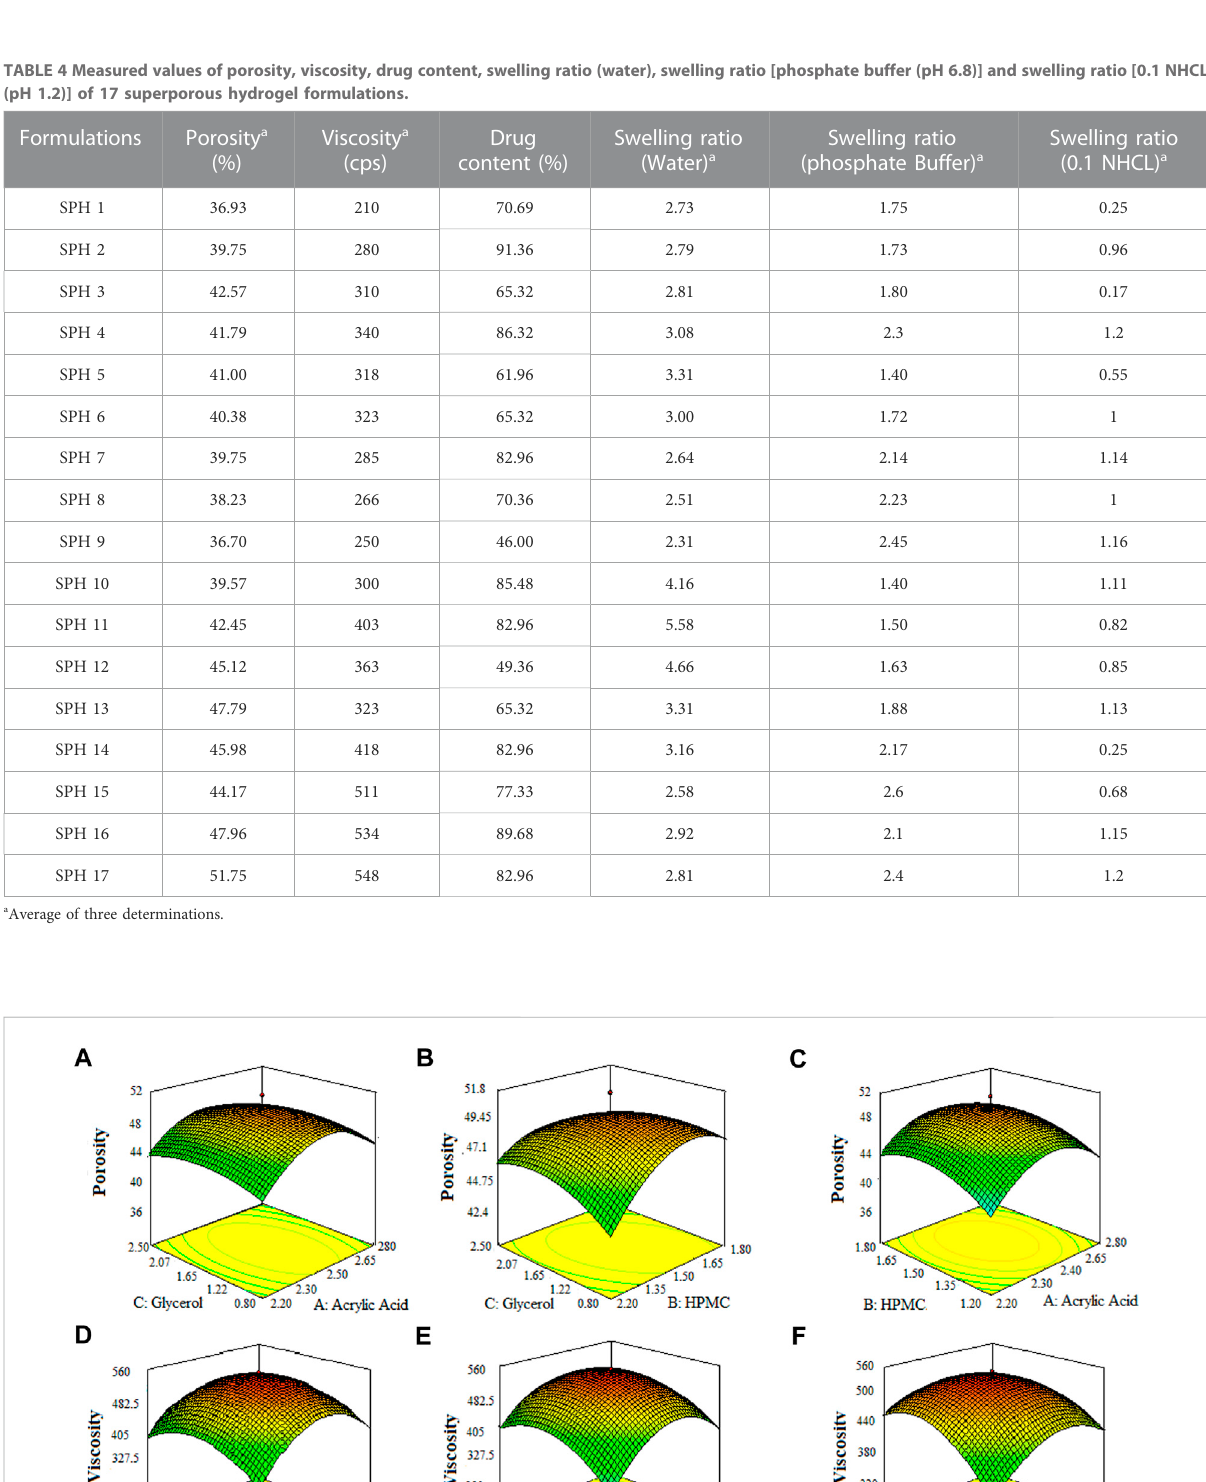
TABLE 4 Measured values of porosity, viscosity, drug content, swelling ratio (water), swelling ratio [phosphate buffer (pH 6.8)] and swelling ratio [0.1 NHCL (pH 1.2)] of 17 superporous hydrogel formulations. Formulations